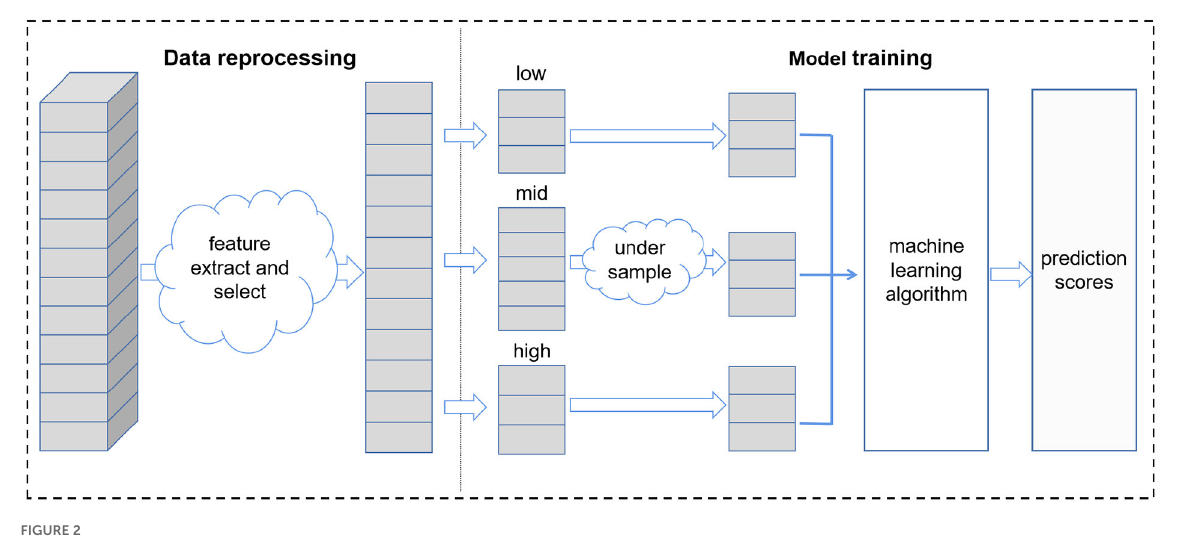
FIGURE2 The process of model training.